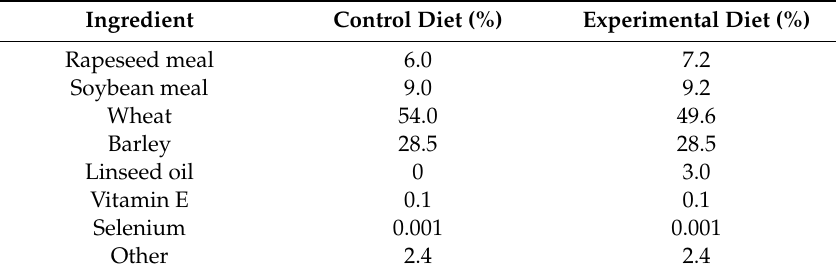
Table 1. Composition of pigs’